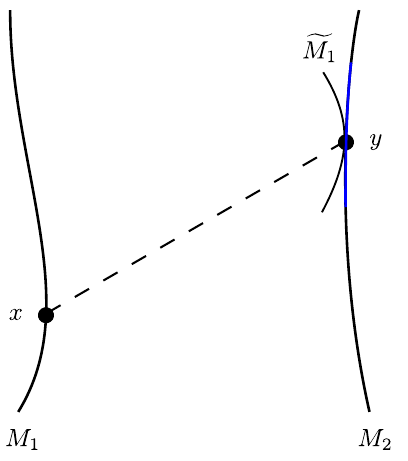
Figure 8 . We assume that the points x; y on M 1 ; M 2 respectively are null separated (dashed line). Part of the representative f M 1 is depicted in blue and is tangent to M 2 . By applying the touching lemma to the pictured setup we arrive at a contradiction, proving that no two points on M 1 ; M 2 are null